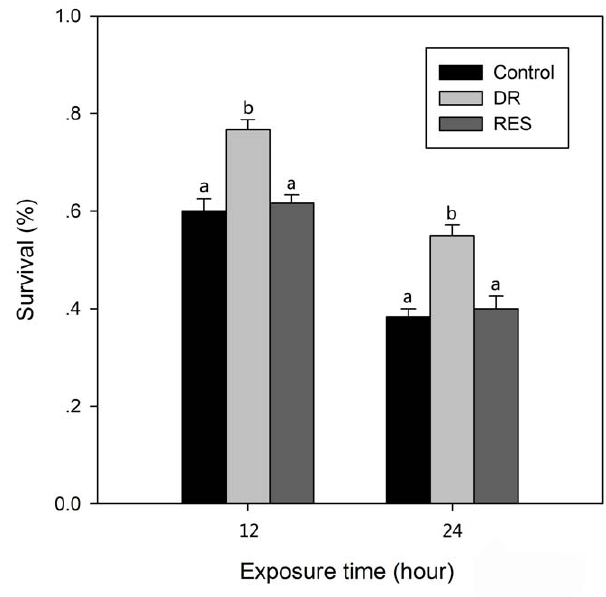
Figure 9. The survival rate of B. calyciflorus under oxidative stress conditions (paraquat). The survival rate was statistically analyzed by one-way ANOVA and post-hoc Duncan multiple range test. The different letters indicate a significant difference for each time point with control ( P , 0.05).